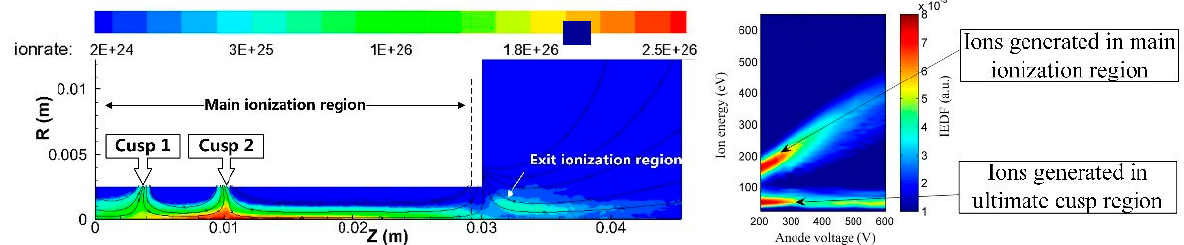
Figure 13. Simulation and experimental results of the two ionization regions characteristics.